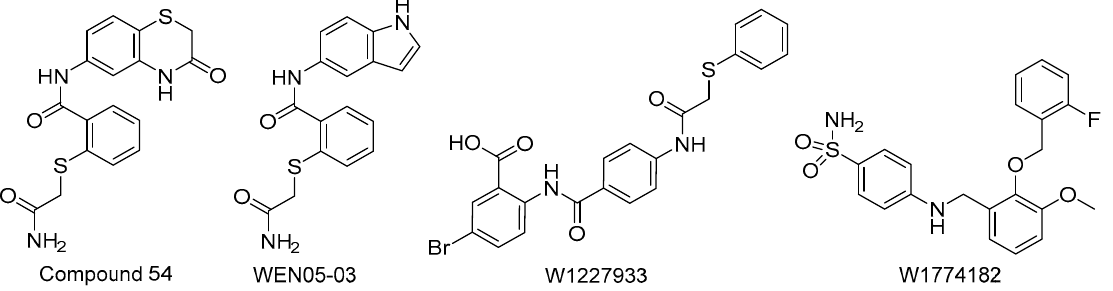
Figure 16. Structures of Compound 54 , WEN03-05, W1227933, and